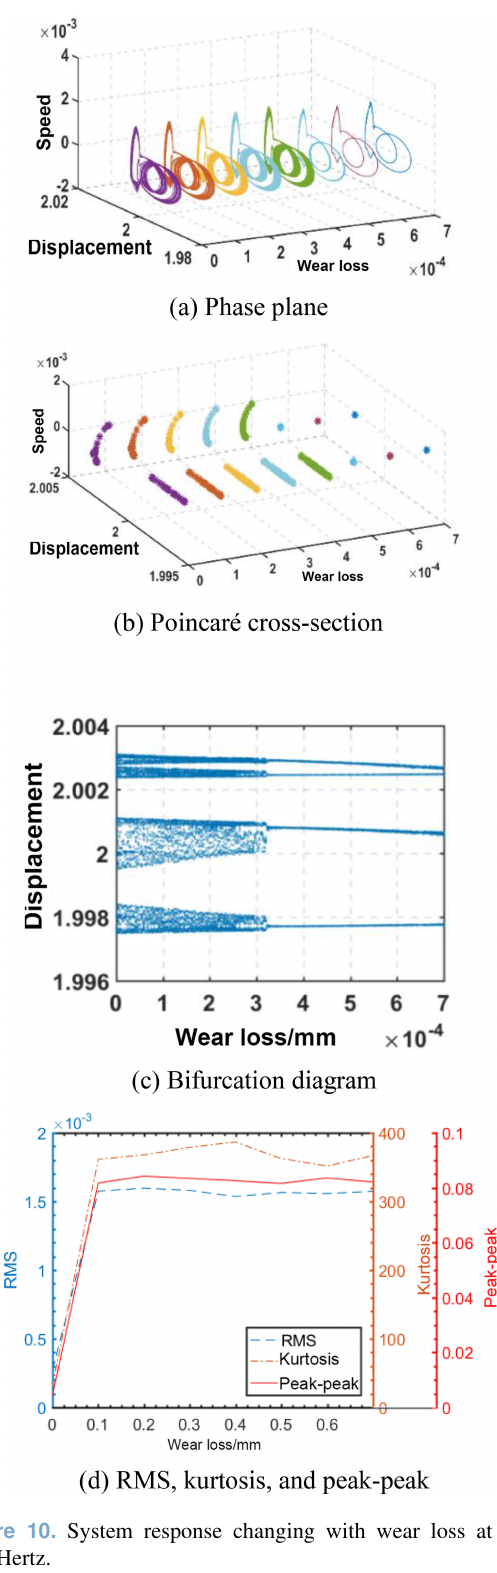
Figure 10. System response changing with wear loss at w k = 72 . 5 Hertz.